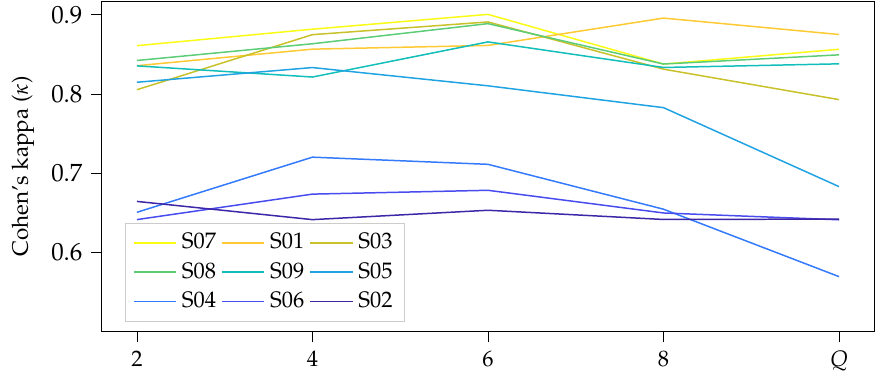
Figure 3. Cross-validated classification performance along the number of components.